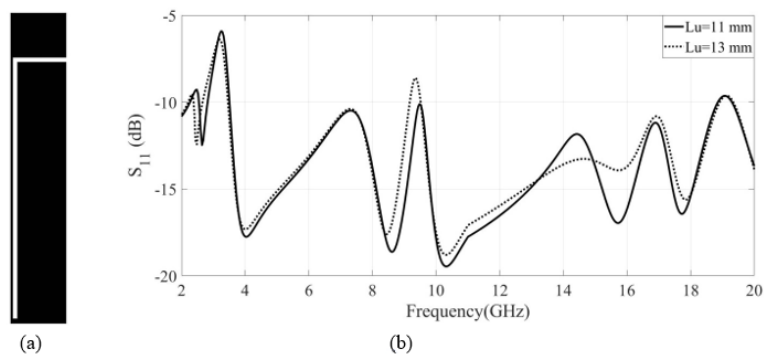
Figure 3. ( a ) Geometry of L u shaped slit at the radiating patch; ( b ) S 11 parameter for different lengths of an inverted L-shaped slit (i.e., L u = 11 mm, 13 mm) for WiMax band